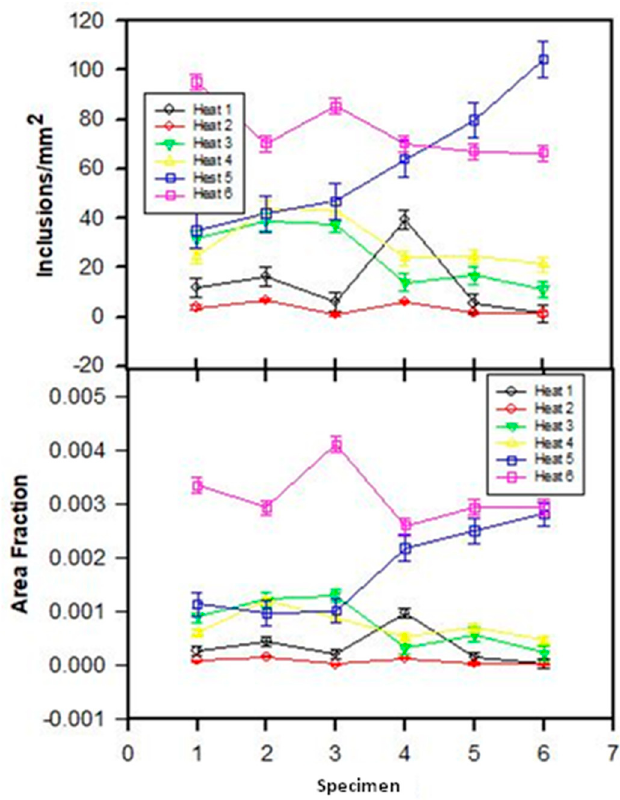
Figure 2. Evolution of inclusions/mm 2 and area fraction of inclusions.